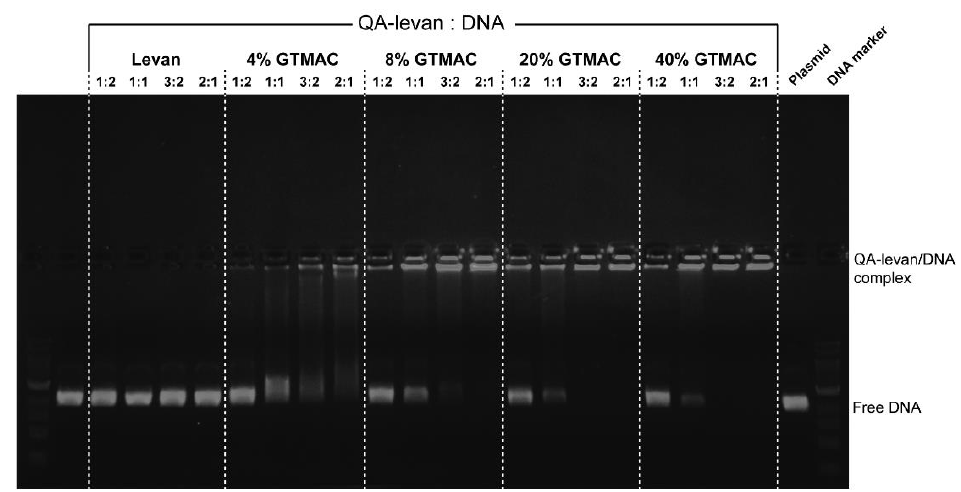
Figure 3. Gel Electrophoresis image of the levan and QA − levan (0.1 – 0.4 μ g) synthesized by different concentration of GTMAC bound to pBlueScript II SK (-) plasmid (0.2 μ g).